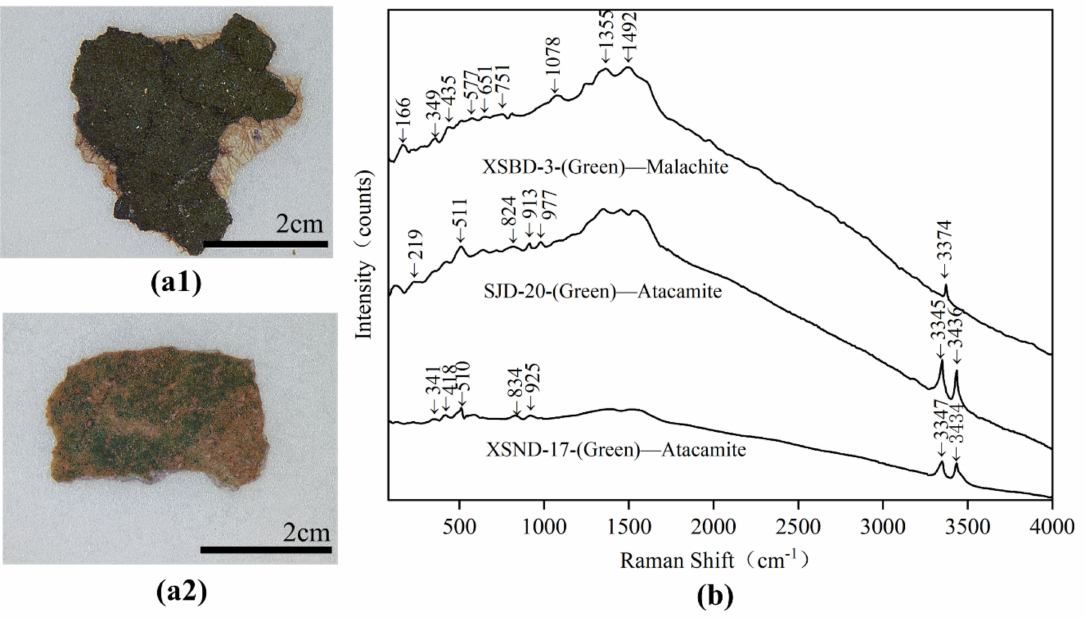
Figure 11. Digital microscopy (DM) of green samples ( a1 ) XSND-17; ( a2 ) XSBD-3 and Micro-Raman spectroscopy ( b ) XSBD-3; SJD-20 and